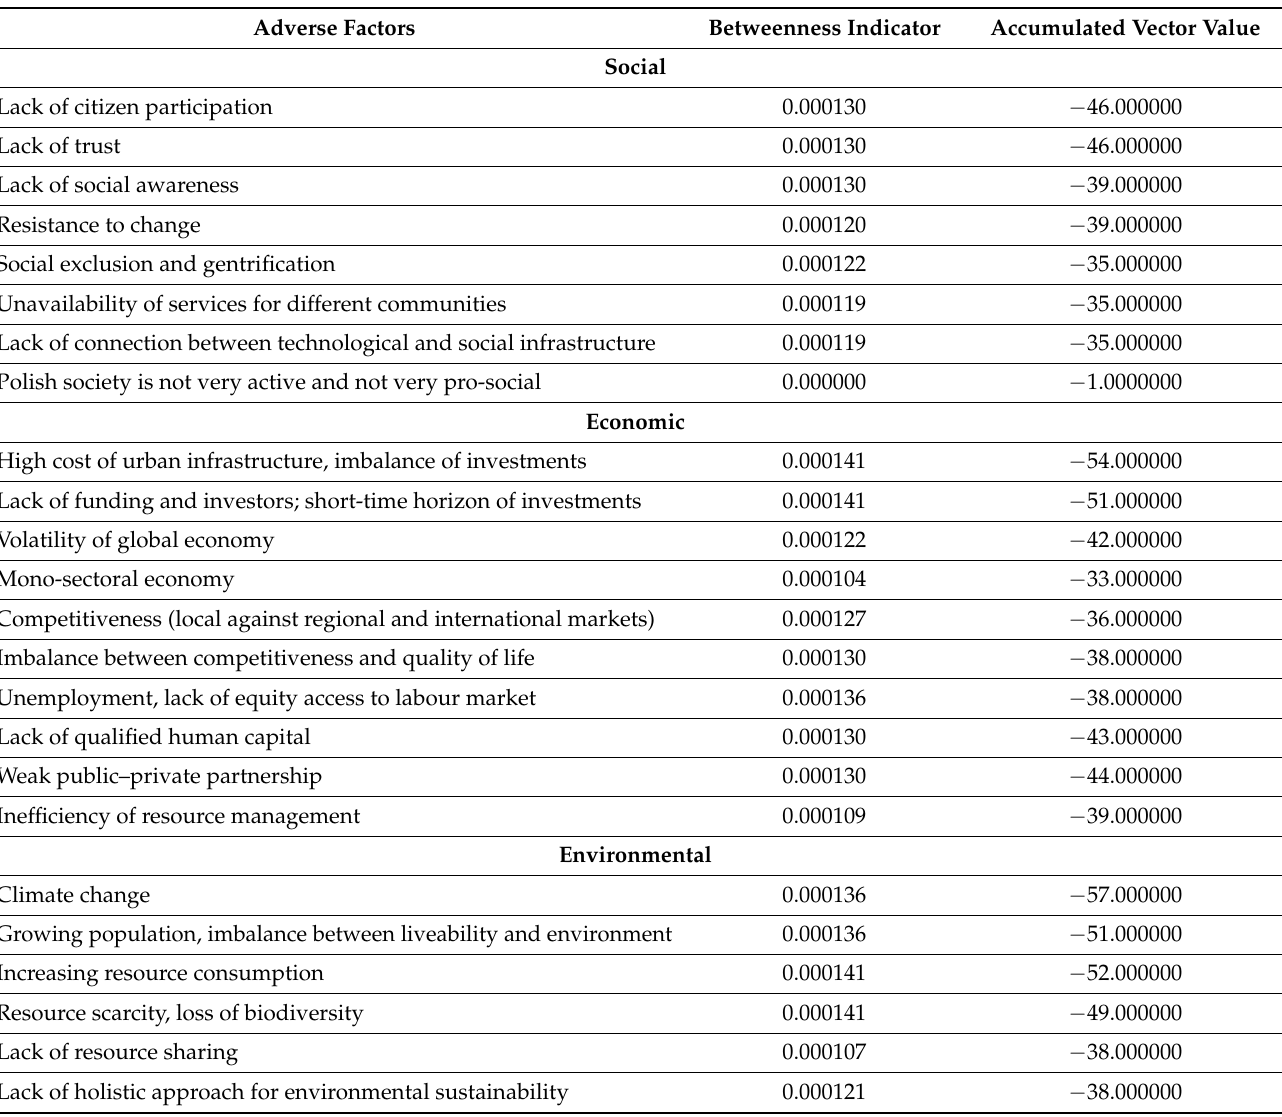
Table A9. Cumulative list of scoring for the adverse factors of the development of smart cities in Poland based on expert opinion. Source: Own